Question: What type of chart is this?
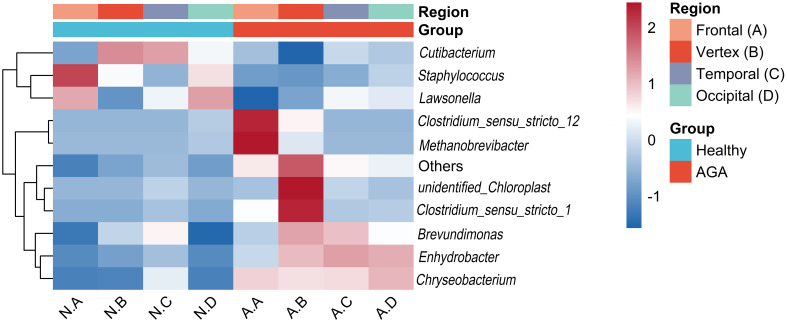
Answer: heatmap